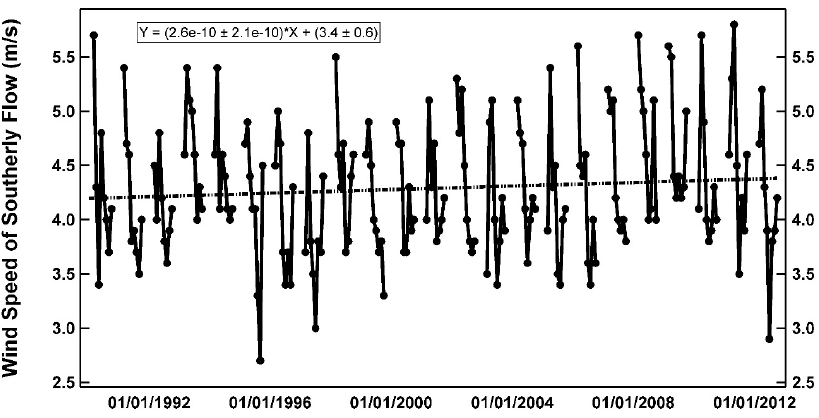
Figure 11. Time series of the monthly averaged wind speed of southerly flow for the Houston